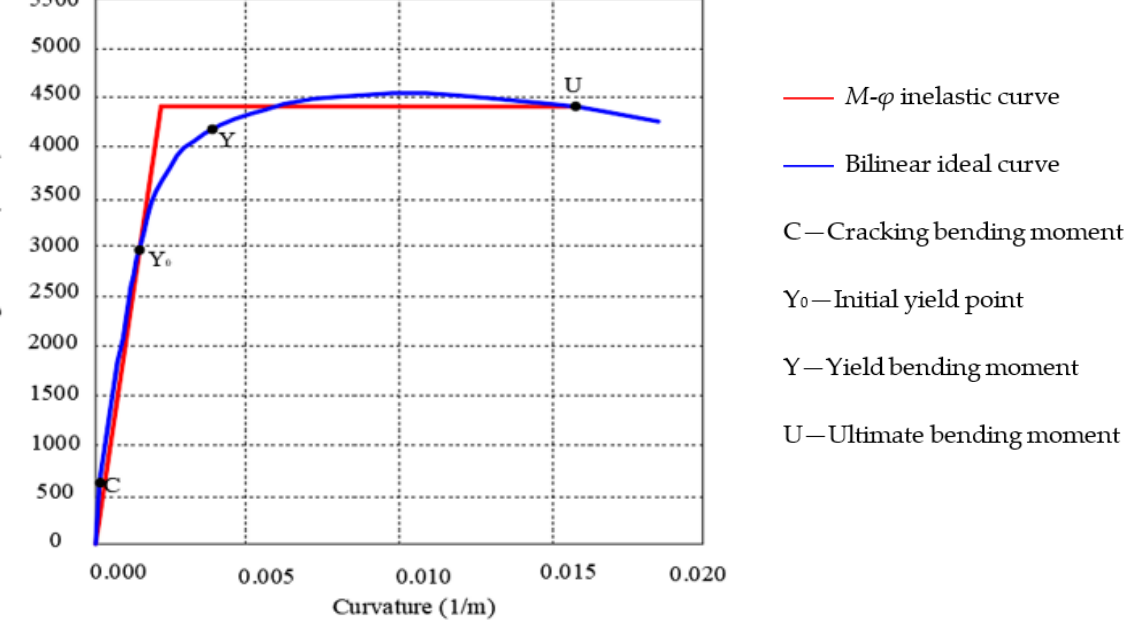
Figure 7. Plot of the moment–curvature relationship of the cross section of the bridge pier.